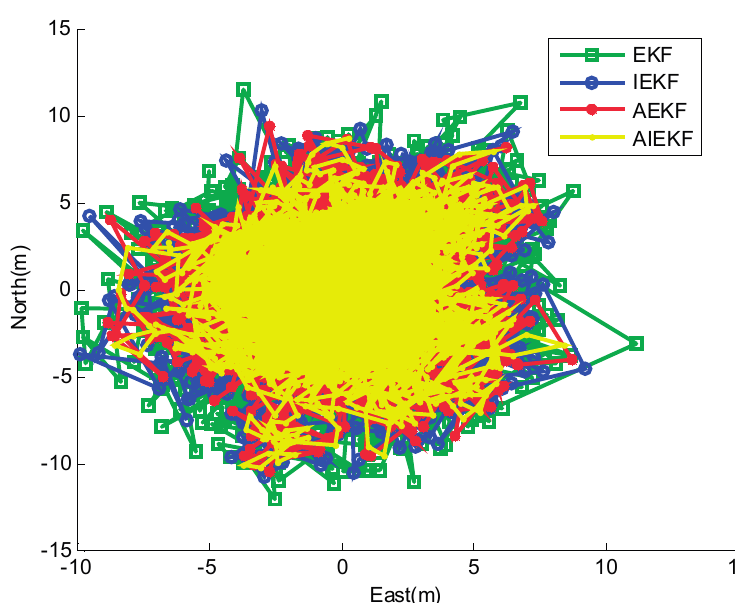
Figure 14. Static positioning result.